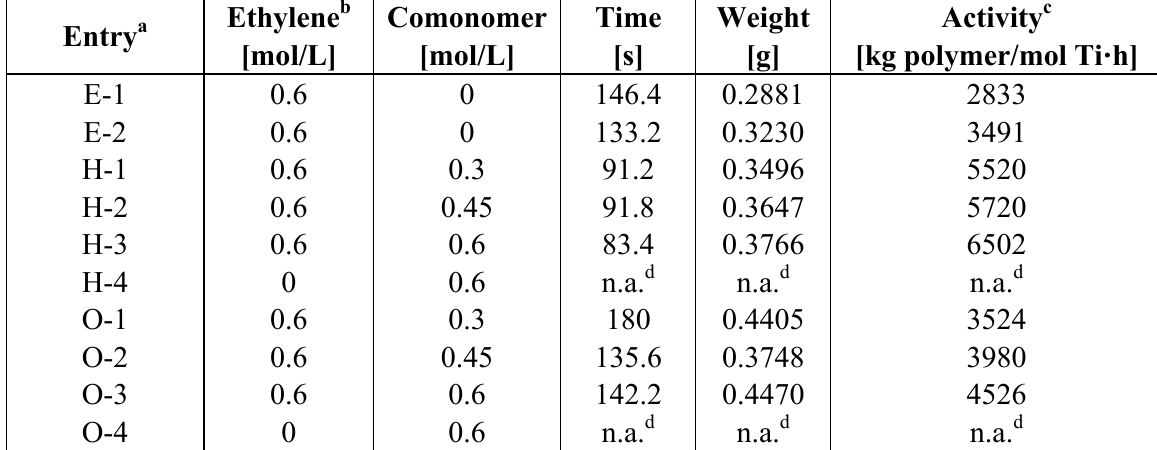
Table 1. Summary of ethylene/ α -olefins copolymerization catalytic